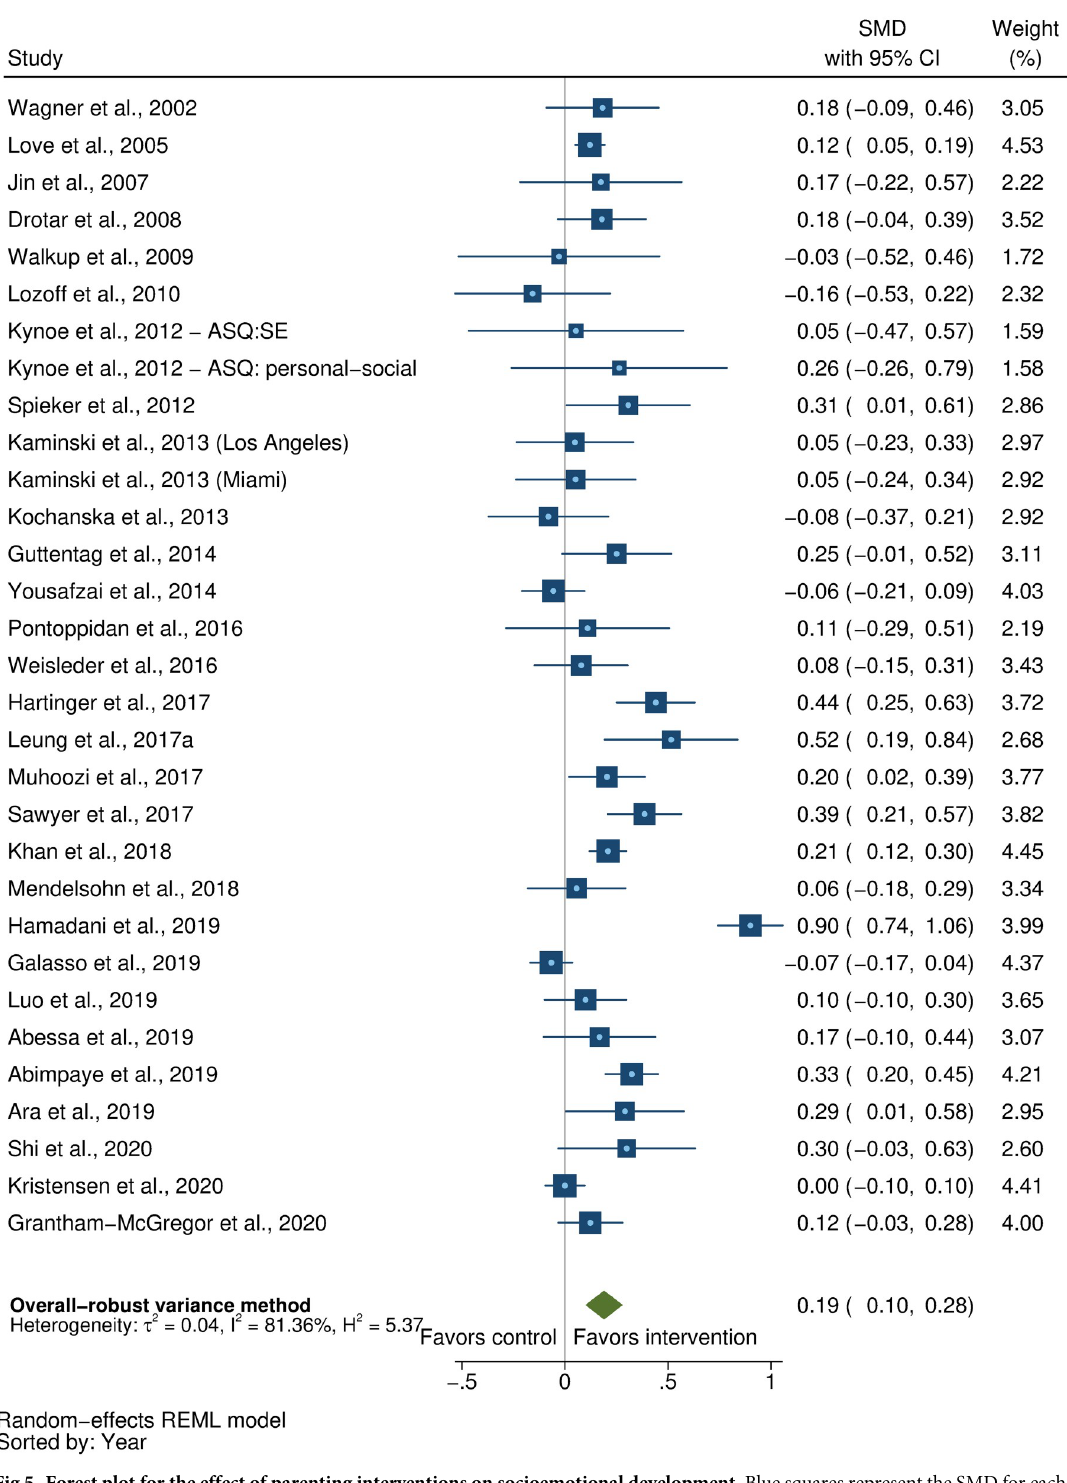
PLOS Medicine| https://doi.org/10.1371/journal.pmed.1003602 May 10, 2021 28 /